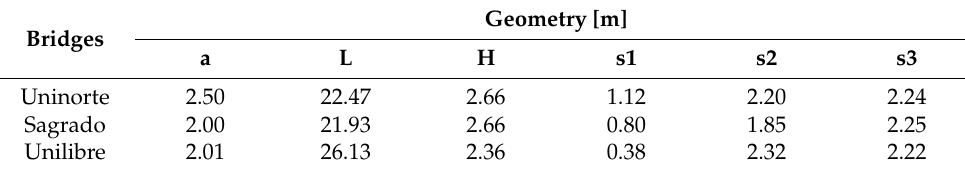
Figure 12. First four vertical modes of vibration obtained from the initial numerical model of the bridges.